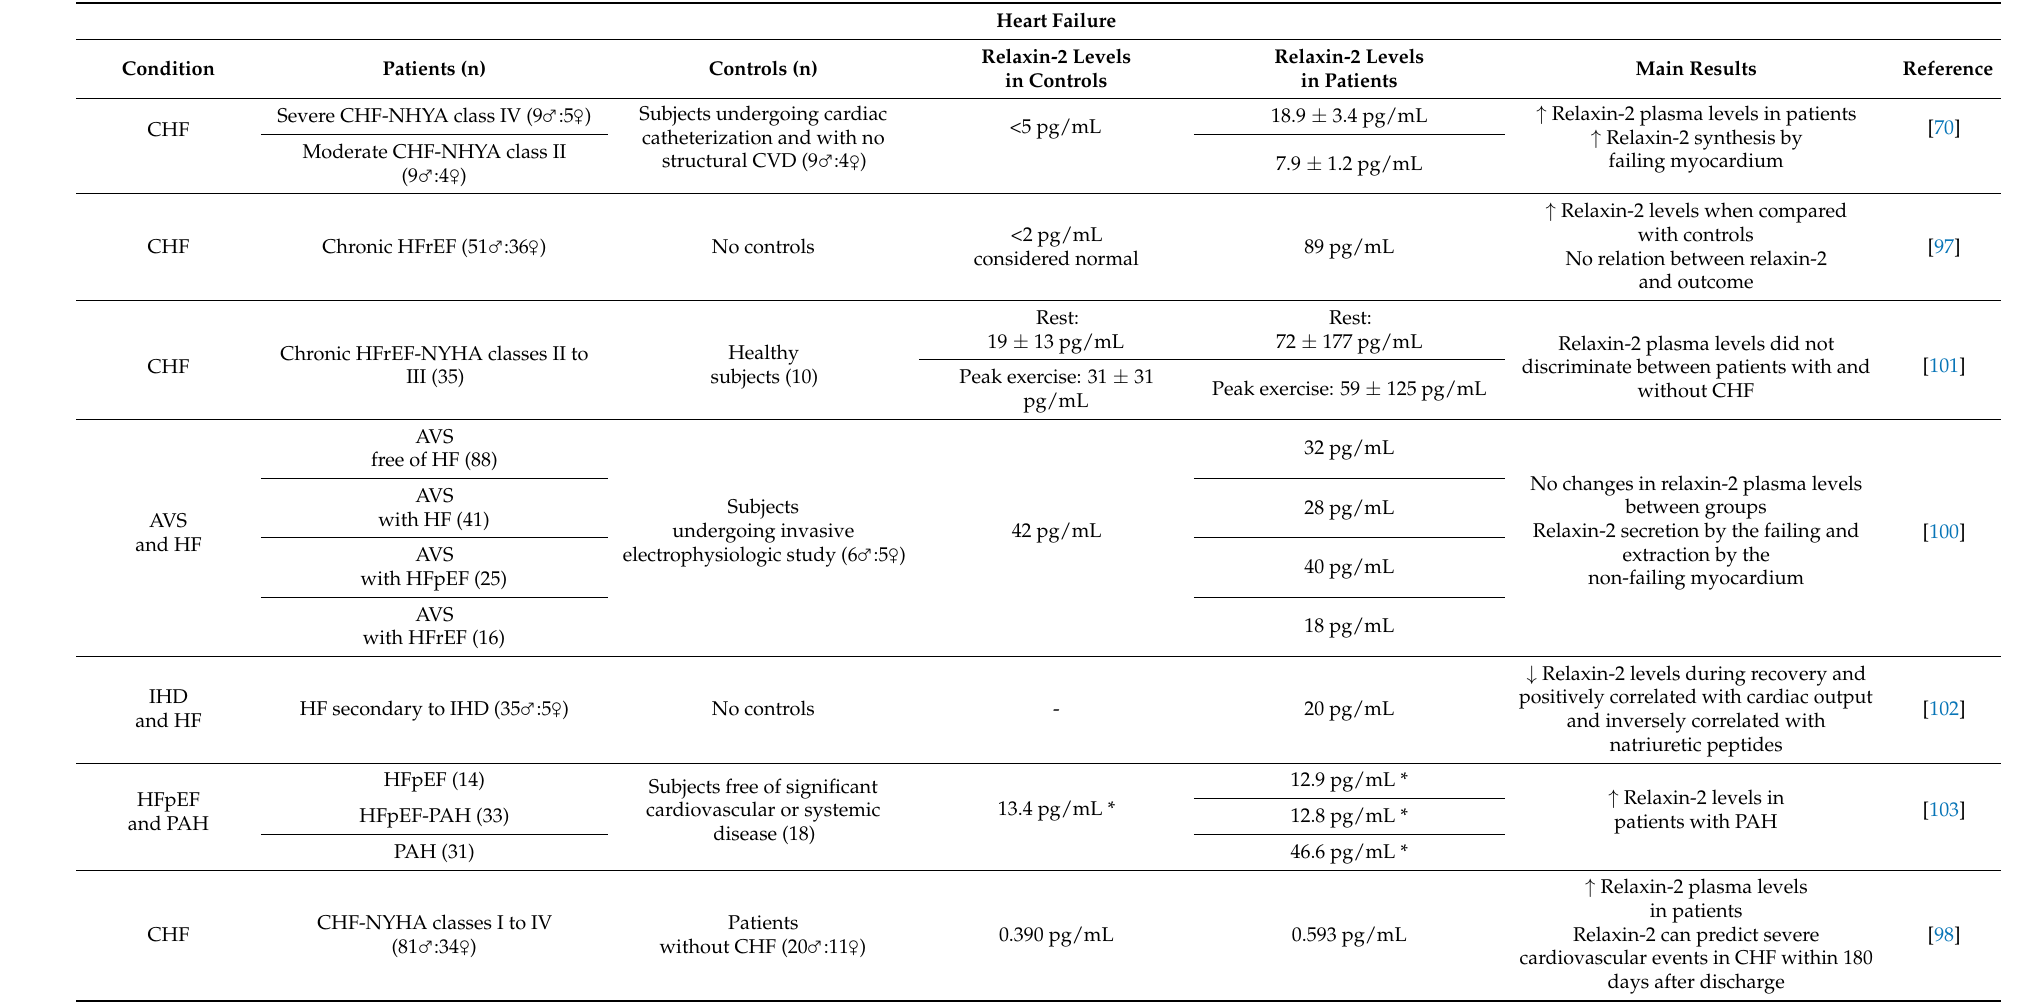
Table 2. Relaxin-2 plasma or serum levels in different settings of heart